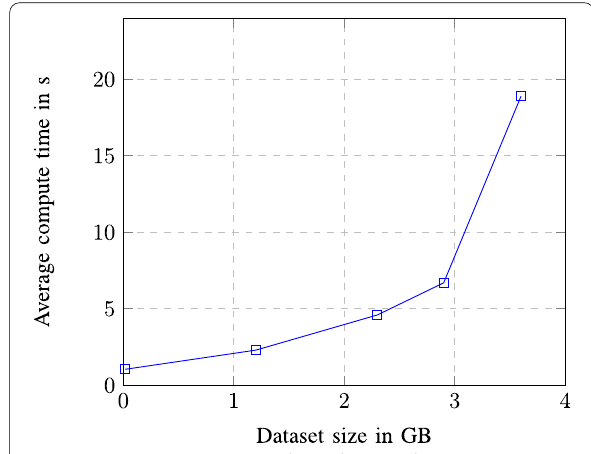
Fig. 10 Average compute time dependence in dataset